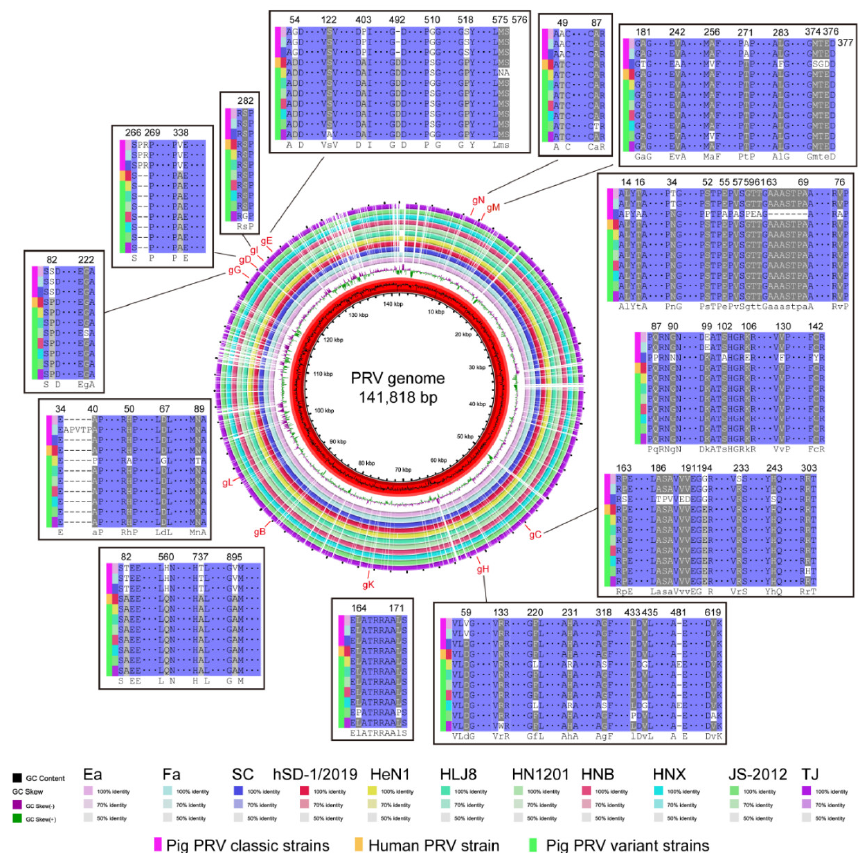
Figure 3. Circle map showing complete genome sequence alignments of human-originated and pig-originated PRV strains. Alignments of amino acid sequences of glycoproteins between different PRV strains were also displayed. Only sites with different amino acid residues are shown.